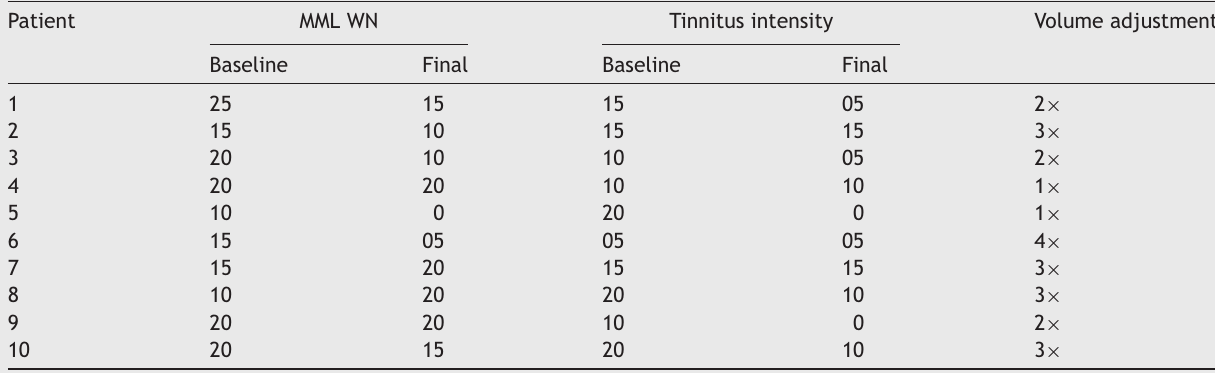
Baseline and final intensity (dB) of tinnitus and volume (dB) of minimum masking levels (MML) with white noise (WN) in sensation level, and the number of times the generator volume was adjusted.